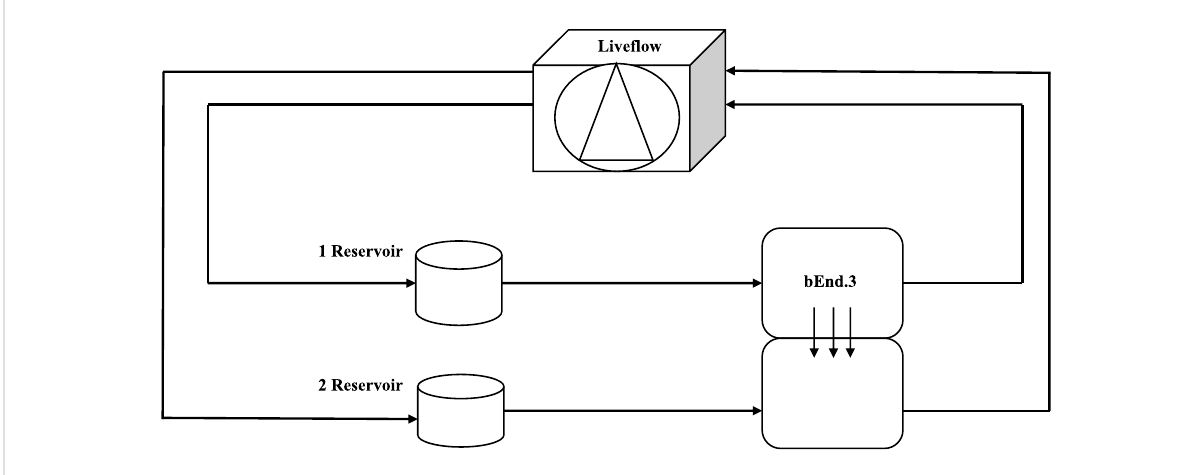
FIGURE 1 Schematicviewofadynamicbioreactor:LiveBox2(LB2)iscomposedofanupperchamberconnectedtoamediumreservoirandtoaLive fl